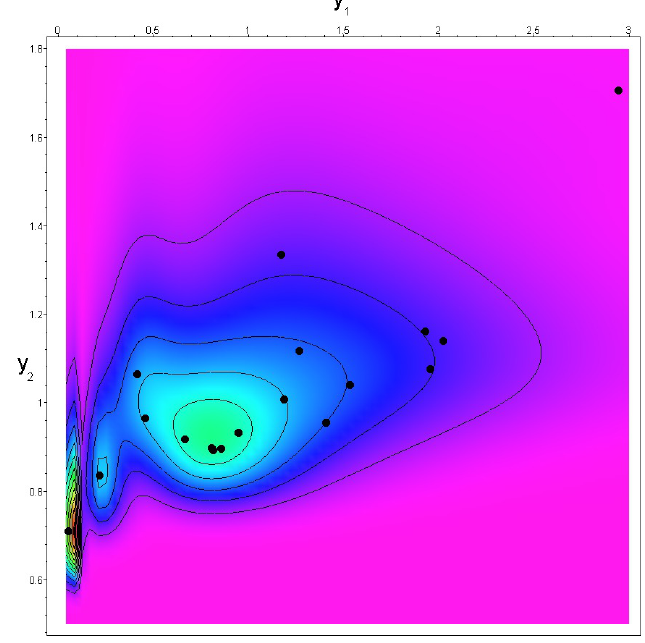
Figure 14. Bivariate density contour plot, kernel density estimate. For the kernel density estimate, the parameters σ = 0.3 and α = 7 were